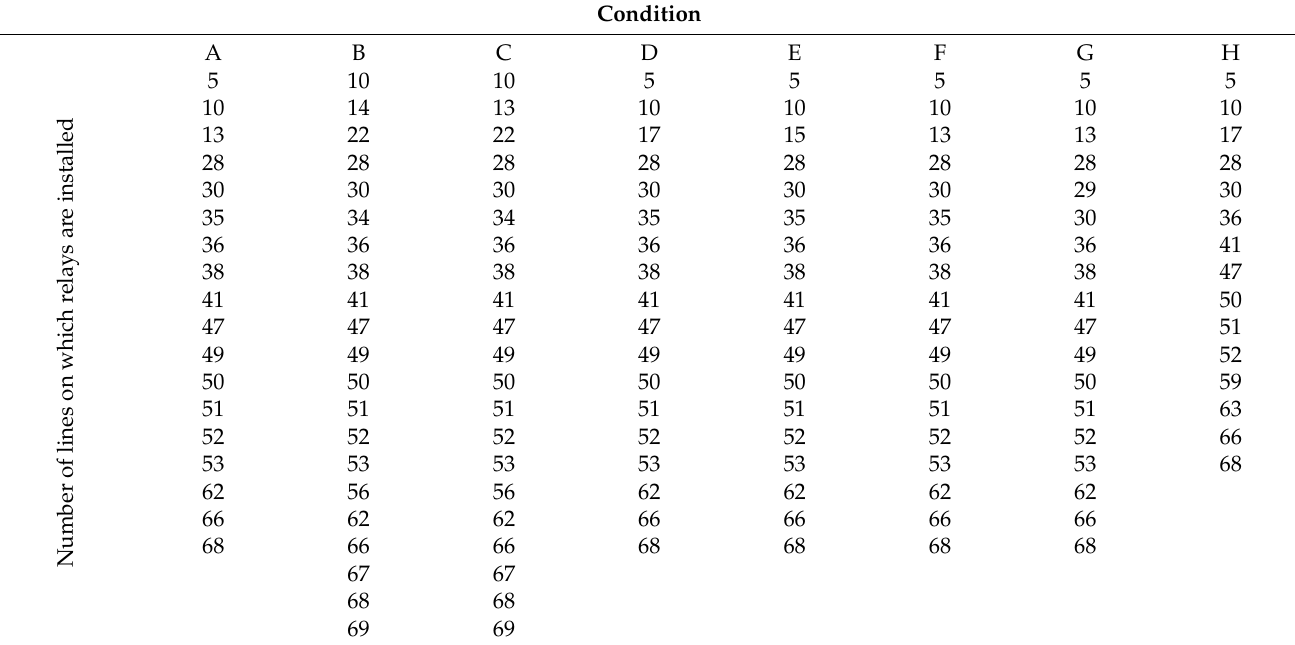
Table 3. Studied condition and number of lines on which relay are